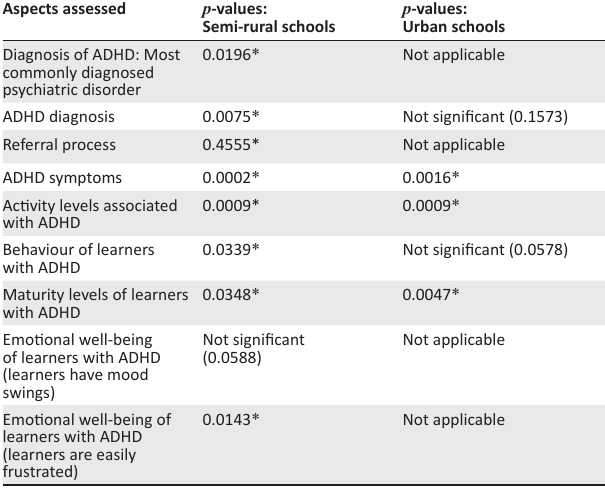
TABLE 3: Outcomes of participants’ awareness and general knowledge of attention deficit hyperactivity